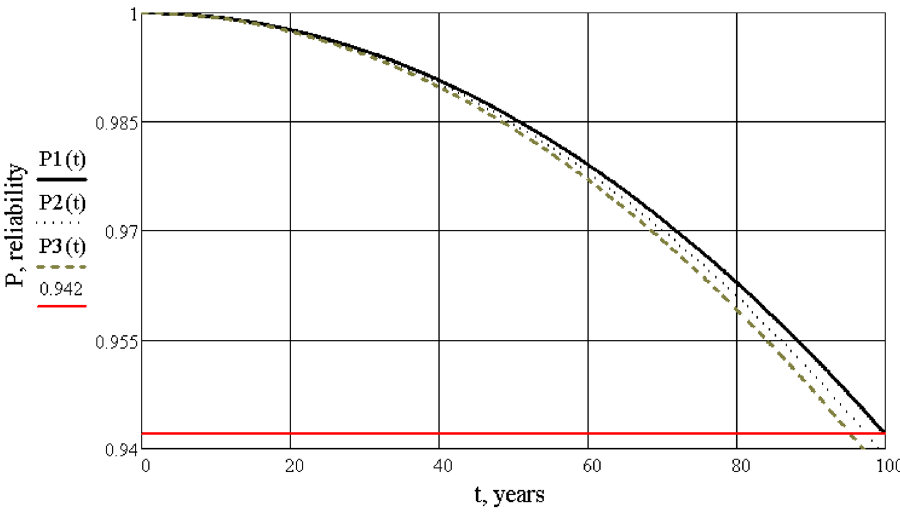
Figure 7. Graphs of reliability dependence of the “building-base system” on time, during a standard cycle of operation.